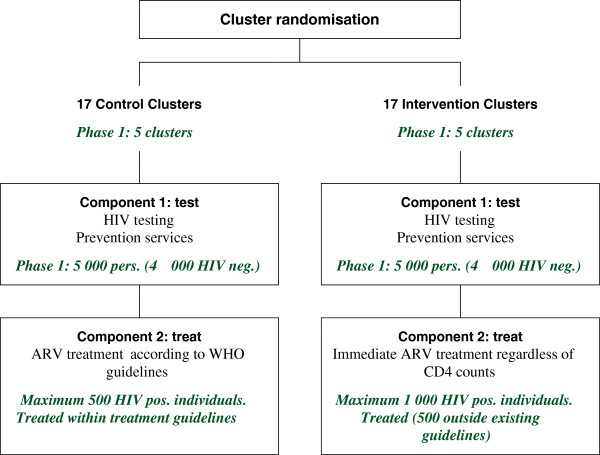
Description of the different components of the ANRS 12249 TasP trial.